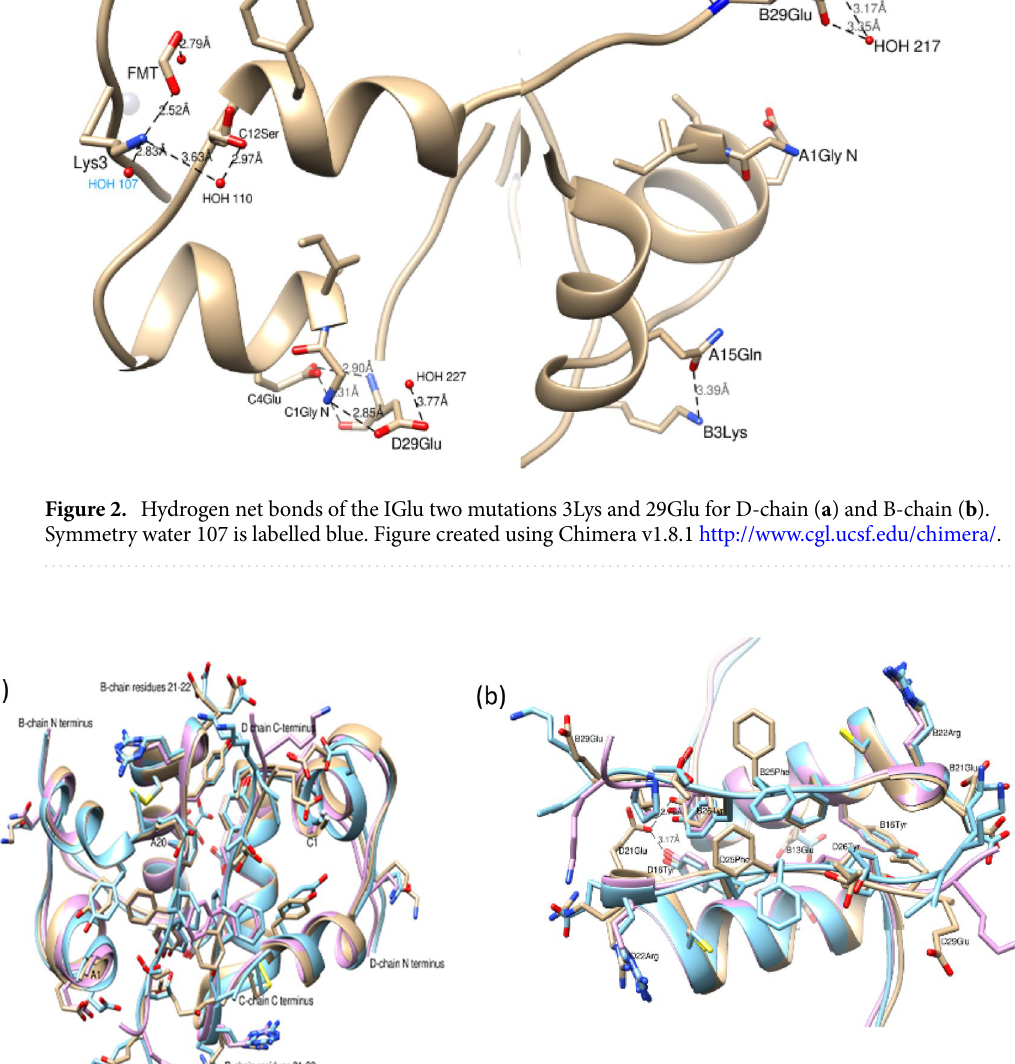
formation. Smaller changes but notable ones, can be seen for the extended T region of these chains (residues 1–8) of the B chain but not (less for) the D. Comparison to human insulin dimers and hexamers. It was found that residues B8Gly–B9Ser, B12Val–B13Glu, B16Tyr, B24Phe–B26Tyr and the C-terminal of the B chain are important for dimer creation and residues B1Phe–B7Cys B10His, B14Ala, B17Leu, B20Gly and A13Leu are essential for the hexamers. Super- position of IGlu, 4EY9 and 4INS show smaller changes for the D8–D12 residues compared with the B-chain (Fig. 3a). Nevertheless, IGlu D main chain is slightly diverted at D13Glu (about 0.6 Å distance) between the C atoms (same for N atoms) of IGlu and those of 4EY9 and 4INS. In addition, the D13Glu side chain is pointed to towards D10His, results in hydrogen bond to the N atom of D13His which is not found for D13Glu of the native insulin in 4INS and 4EY9. B13Glu is located at the centre of the hexamer, its side chain position is not conserved within the three mentioned structures. B13Glu in 4INS creates an H-bond with its approximate twofold crys- tallographic symmetry D13Glu (B13Glu OE2 distance to D13Glu OE2 is 2.59 Å) (Fig. 3b). Thus, the hexamer cavity is more closed. In insulin 4EY9, the side chain of B13Glu is located further away from the centre and thus makes hexamer cavity wider. Interestingly, the α-turn in the IGlu D chain residues D19Cys (from C atom),